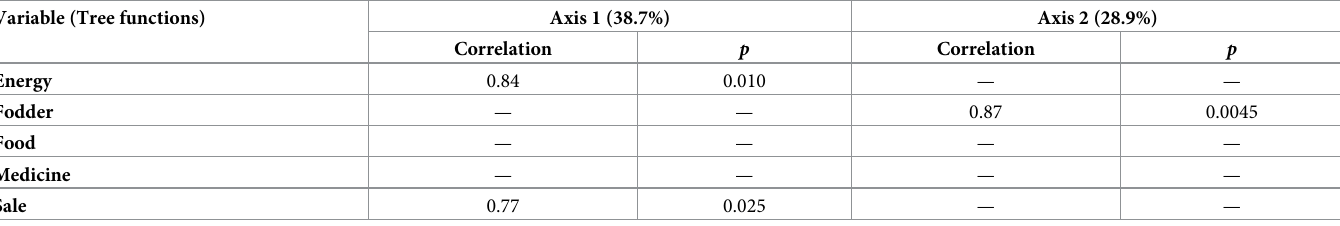
Table 6. Description of the PCA dimensions by their correlation coefficients with the tree functions listed by the respondents of the four villages (Cassou, Dao, Kou and Vrassan) in Ziro province of Burkina Faso and the value of measured variables (abundance of very useful tree species, tree species richness and total score of tree function).